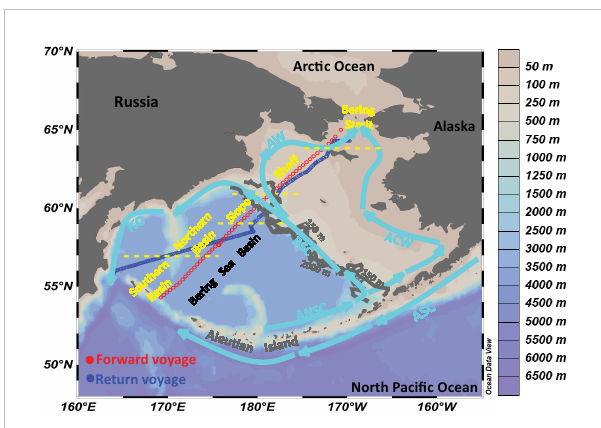
FIGURE 1 Geographic settings in the Bering Sea. Light blue arrows denote the current, modi fi ed from Detlef et al. (2020); Fransson et al. (2006), and Song et al. (2016). Also shown are the underway measurements during the forward voyage in July (red circles) and the return voyage in September (blue circles). KC, Kamchatka Current; ANSC, Aleutian North Slope Current; BSC, Bering Slope Current; ASC, Alaskan Stream Current; ACW, Alaskan Coastal Water; AW, Anadyr